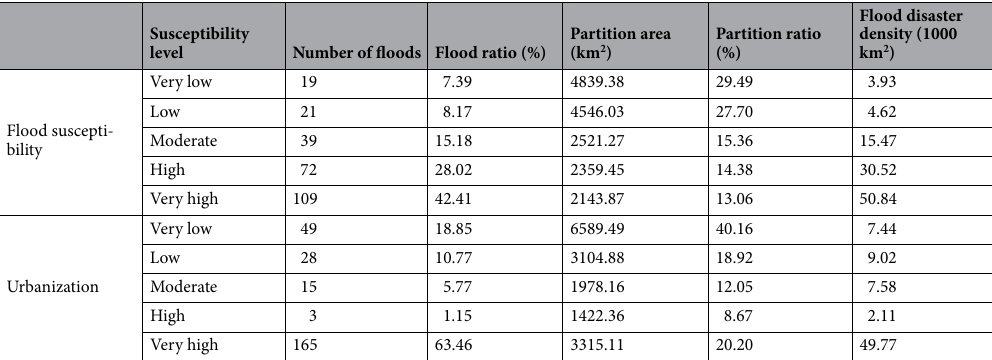
Table 8. Relationship between number of floods and level of susceptible